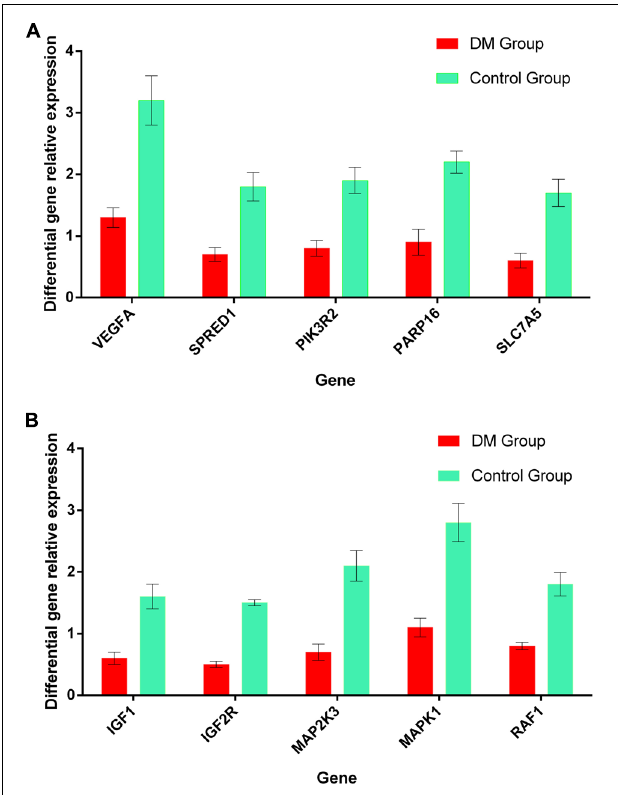
FIGURE 10 | (A) The relative expression levels of the most relevant 5 target genes regulated by miRNA-126 in the plasma of DM and control group. (B) The relative expression levels of the most relevant 5 target genes regulated by miRNA-28-3p in the plasma of DM and control group.